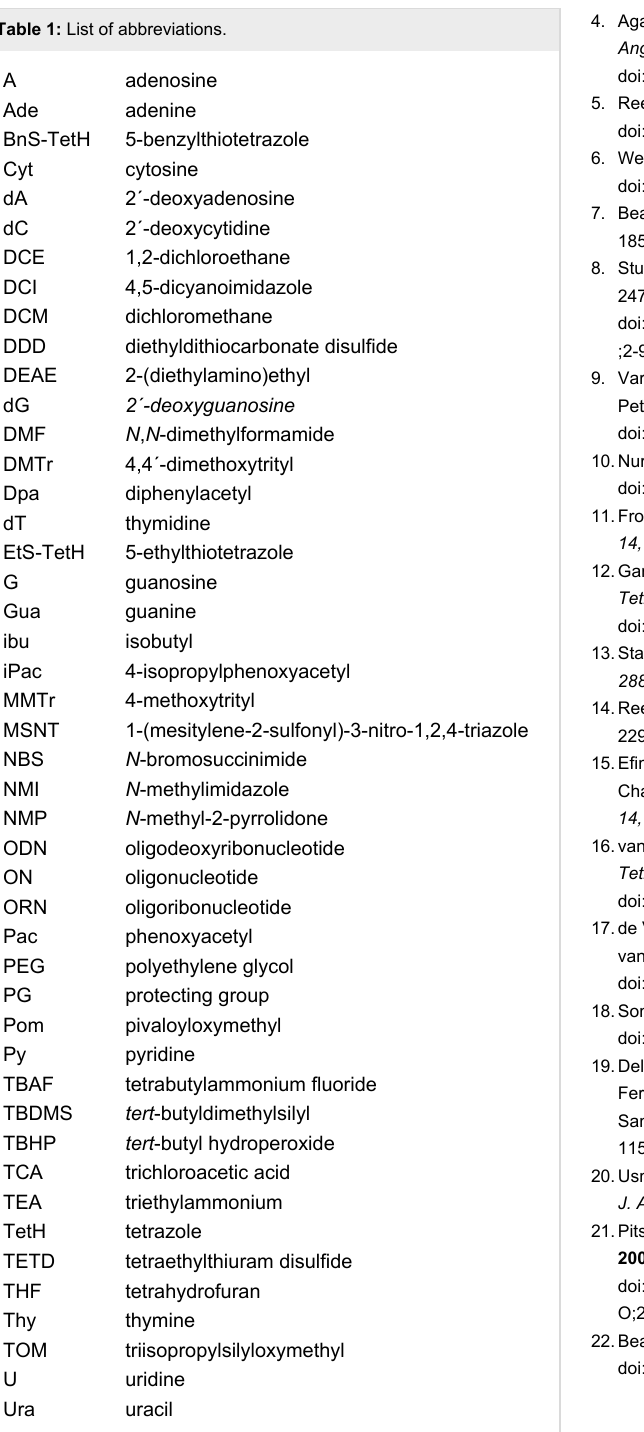
Table 1: List of